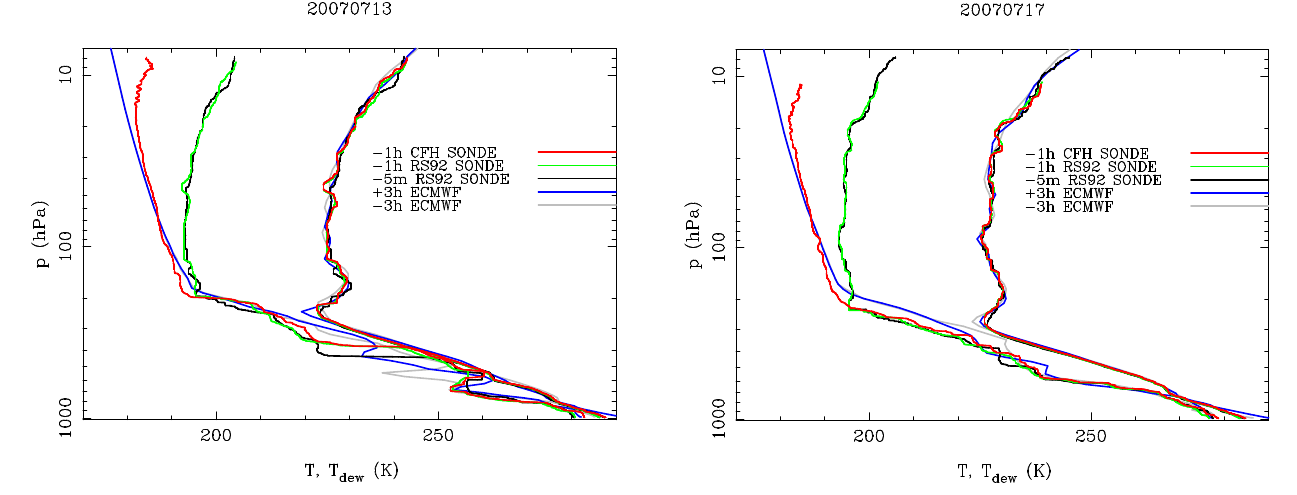
Fig. 4. Temperature (right) and water vapour profiles (left) for the CFH and RS92 sonde launched 1h before overpass time (red and green, respectively), the RS92 sonde launched 5min before IASI overpass (black) and the ECMWF analysis profile approximately 3h before and after satellite overpass (grey and blue, respectively). Note the big moisture variation between the 1h and 5min before overpass launch measurements at the 400hPa-level.